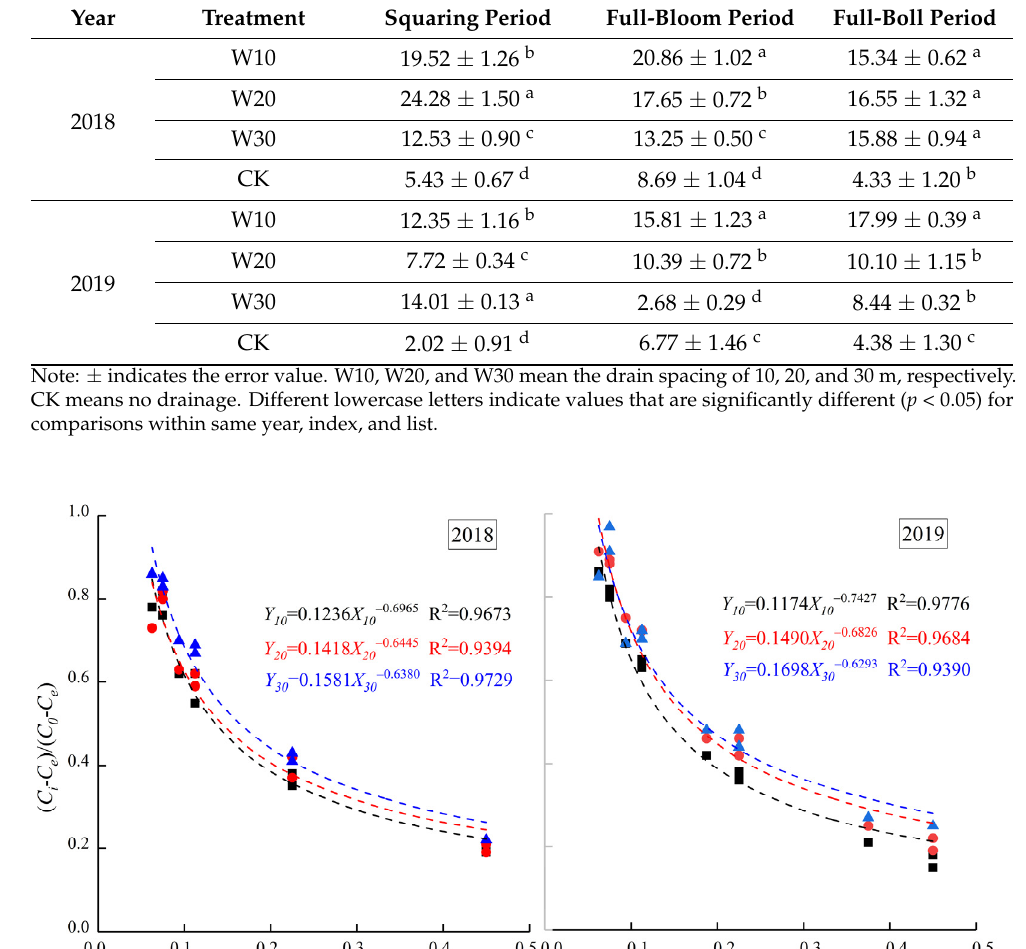
Table 3. Soil salinity leaching rate of drip irrigation, %. Year Treatment